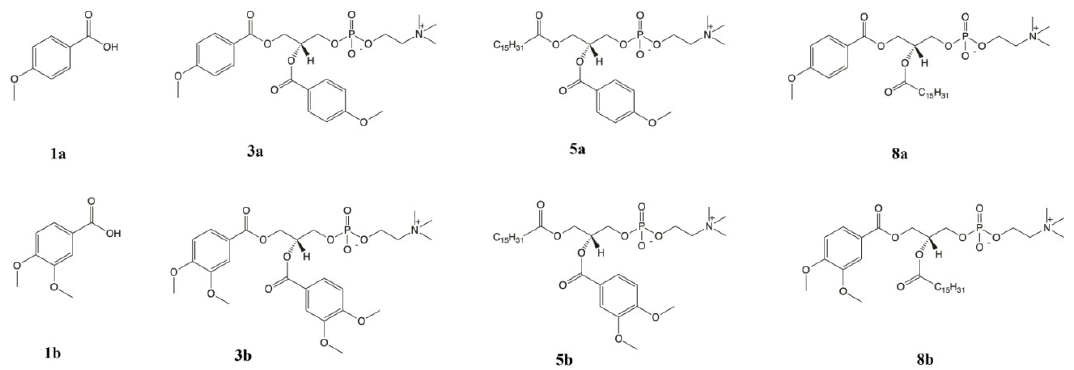
Figure 11. Studied conjugates of phospholipids and methoxy derivatives of benzoic acid: p -anisic acid (ANISA; 1a ), 1,2-dianisoyl- sn -glycero-3-phosphocholine ( 3a ), 1-palmitoyl-2-anisoyl- sn -glycero-3-phosphocholine ( 5a ), 1-anisoyl-2-palmitoyl- sn -glycero-3-phosphocholine ( 8a ), veratric acid (VA; 1b ), 1,2-diveratroyl- sn -glycero-3-phosphocholine ( 3b ), 1-palmitoyl-2-veratroyl- sn -glycero-3-phosphocholine ( 5b ) and 1-veratroyl-2-palmitoyl- sn -glycero-3-phosphocholine ( 8b ).